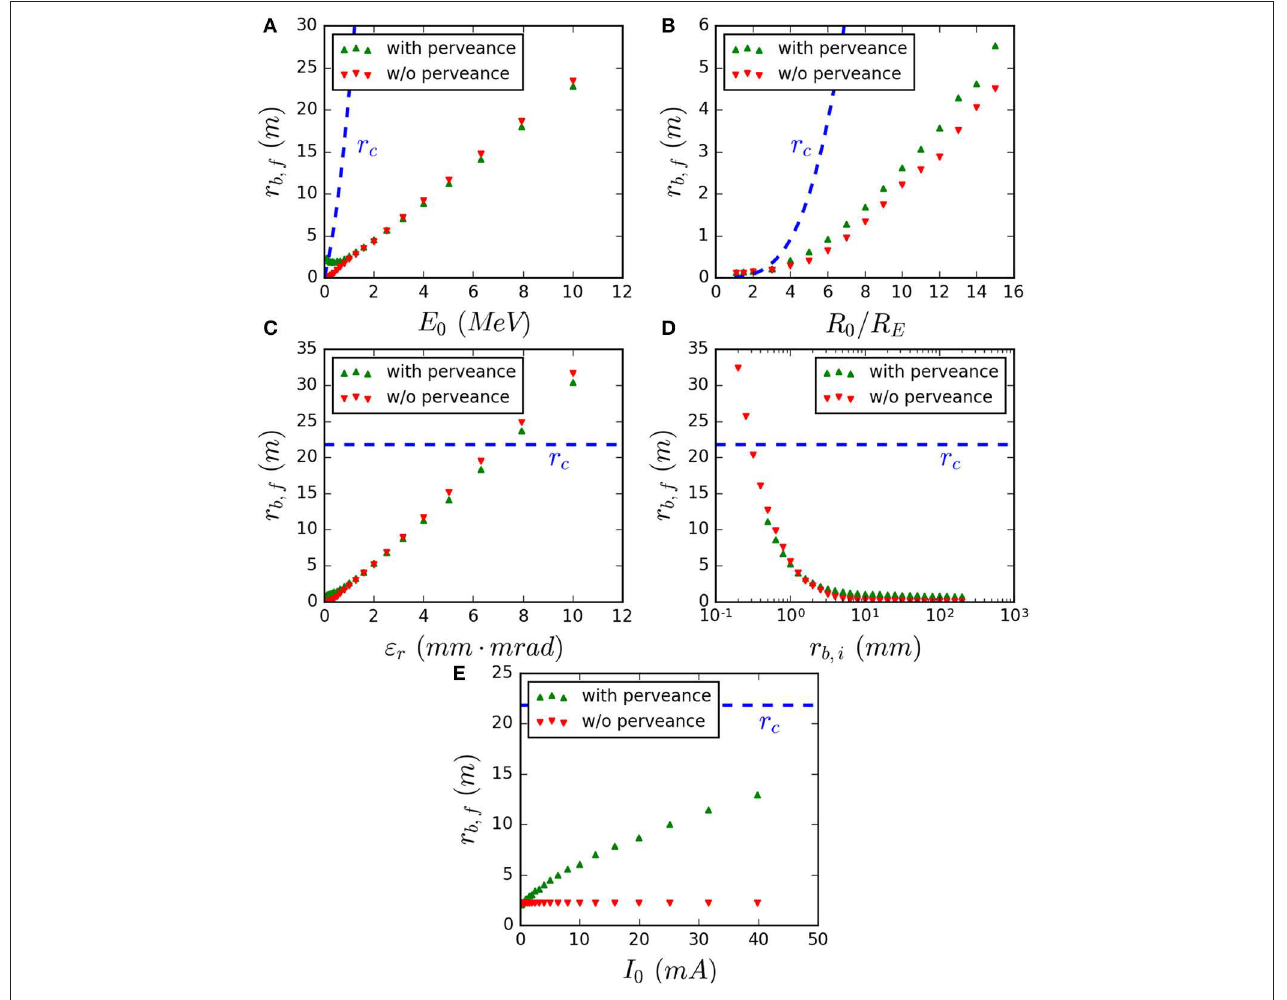
FIGURE 11 | Final RMS beam envelope radius at impact with the Earth with parameter scans in (A) beam energy E 0 , (B) injection radii R 0 , (C) radial emittance ε r , (D) initial beam radius r b , i , (E) injection current I 0 . Blue dashed lines show the equivalent cyclotron radius for each condition as per Equation